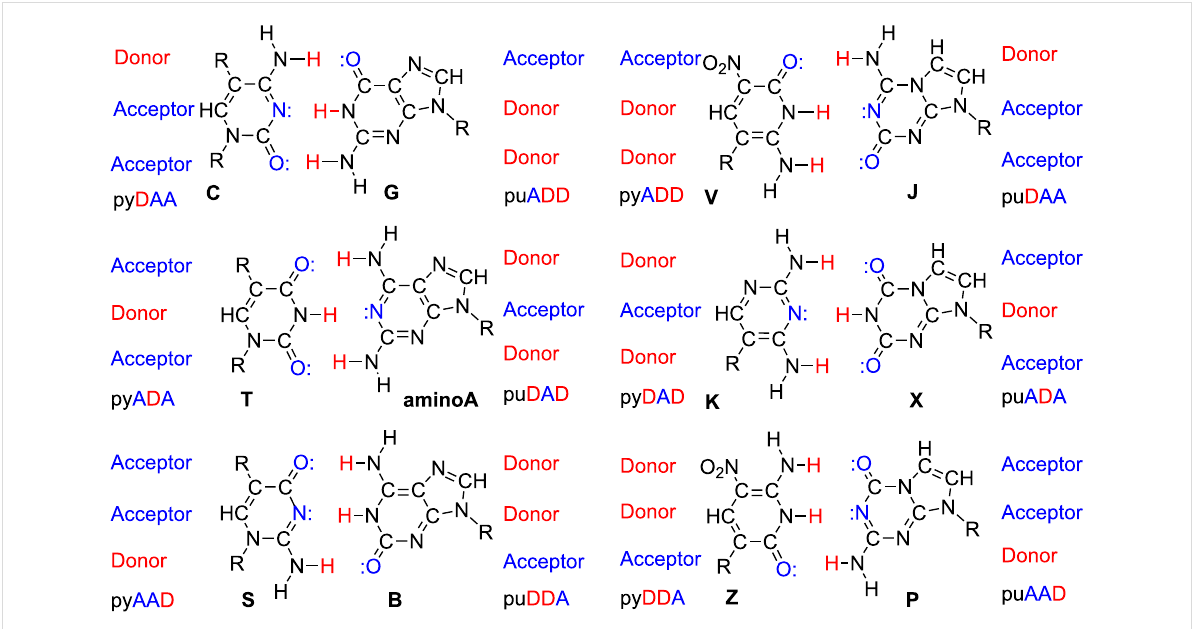
Figure 2: Watson–Crick pairing rules follow two rules of complementarity: (a) size complementarity (large purines pair with small pyrimidines) and (b) hydrogen bonding complementarity (hydrogen bond acceptors, A, pair with hydrogen bond donors D). Rearranging donor and acceptor groups on the nucleobases creates an artificially expanded genetic information system (AEGIS), whose components can independently pair. AEGIS adds informa- tion density to the DNA oligonucleotides, thereby diminishing off-target hybridization and other undesired aggregation/folding motifs. With strength comparable to the G:C pair, AEGIS components form S : B , Z : P , V : J , and K : X